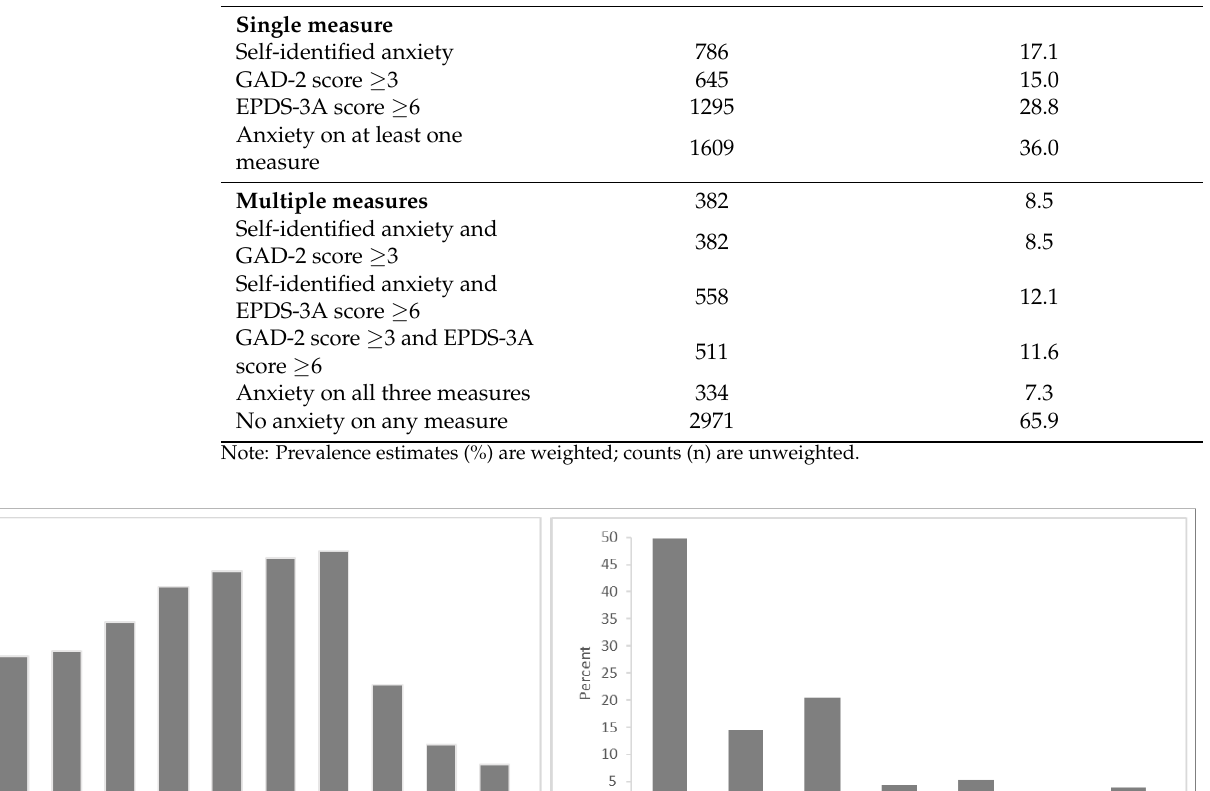
Table 1. Prevalence of postnatal anxiety symptoms on different measures (n = 4508).